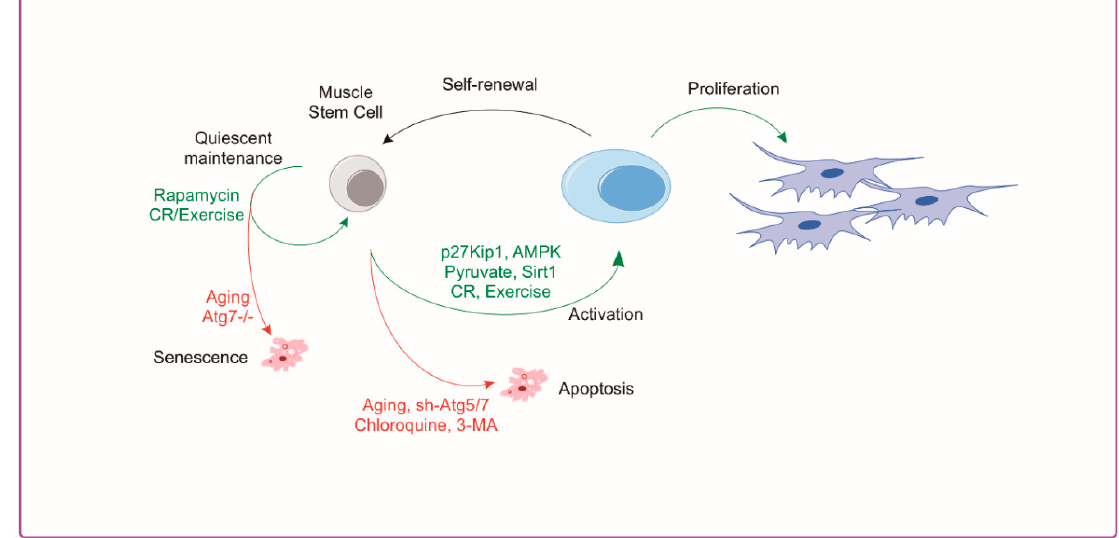
Figure 3. Aging and Autophagy Directly Impact Muscle Stem Cell Activation. Autophagy in the muscle stem cell can directly affect cell fate decisions including the maintenance of quiescence or entering into senescence. These can be controlled by aging, exercise, and caloric restriction or by direct manipulators of autophagy such as rapamycin and genetic ablation of the Atg system. Similarly, muscle stem cell activation requires sufficient energy substrate that can be limiting when autophagy is reduced (i.e., aging or with the autophagy inhibitiors chloroquine or 3-MA). Restoring the energetic signaling through AMPK activation (AICAR) or by supplementing the energy stores through pyruvate can help to replenish stem cell activation.